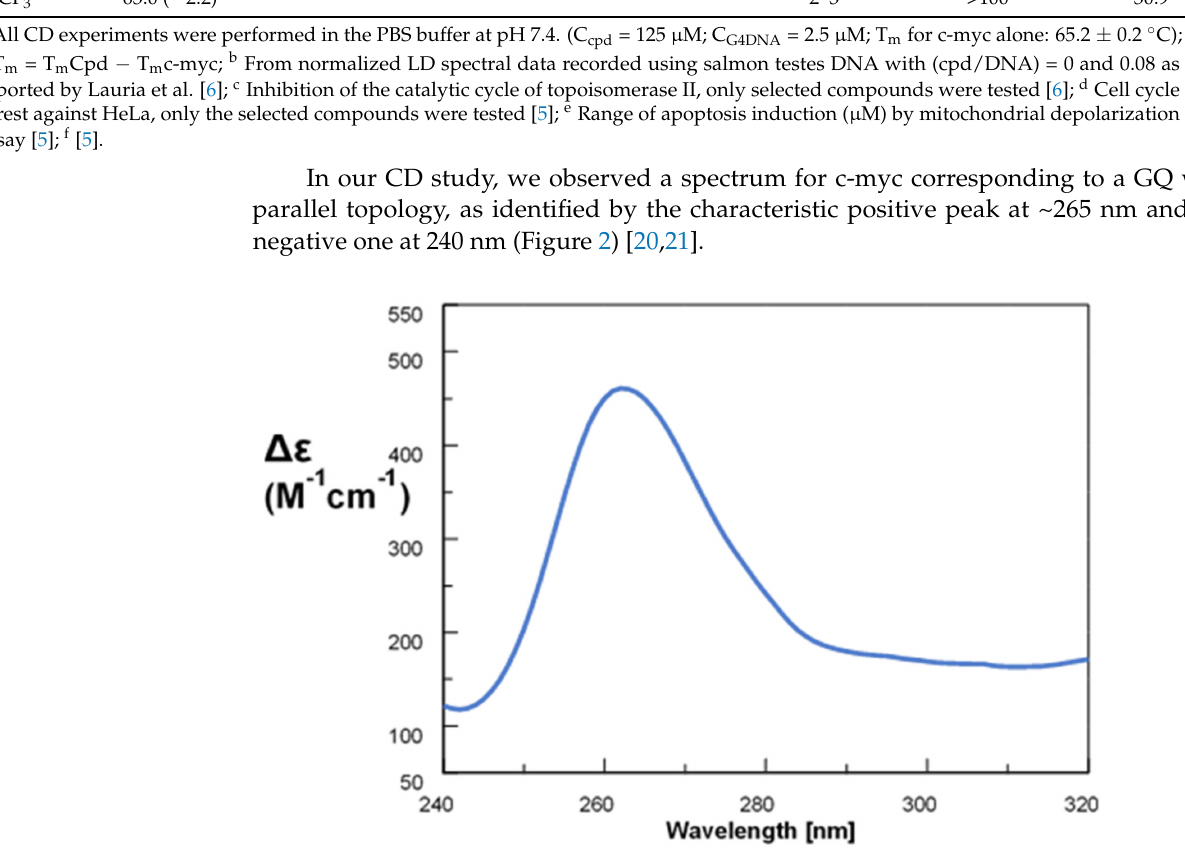
Figure 2. CD spectrum of c-myc 2.5 µ M in 1x PBS (T = 40 ◦